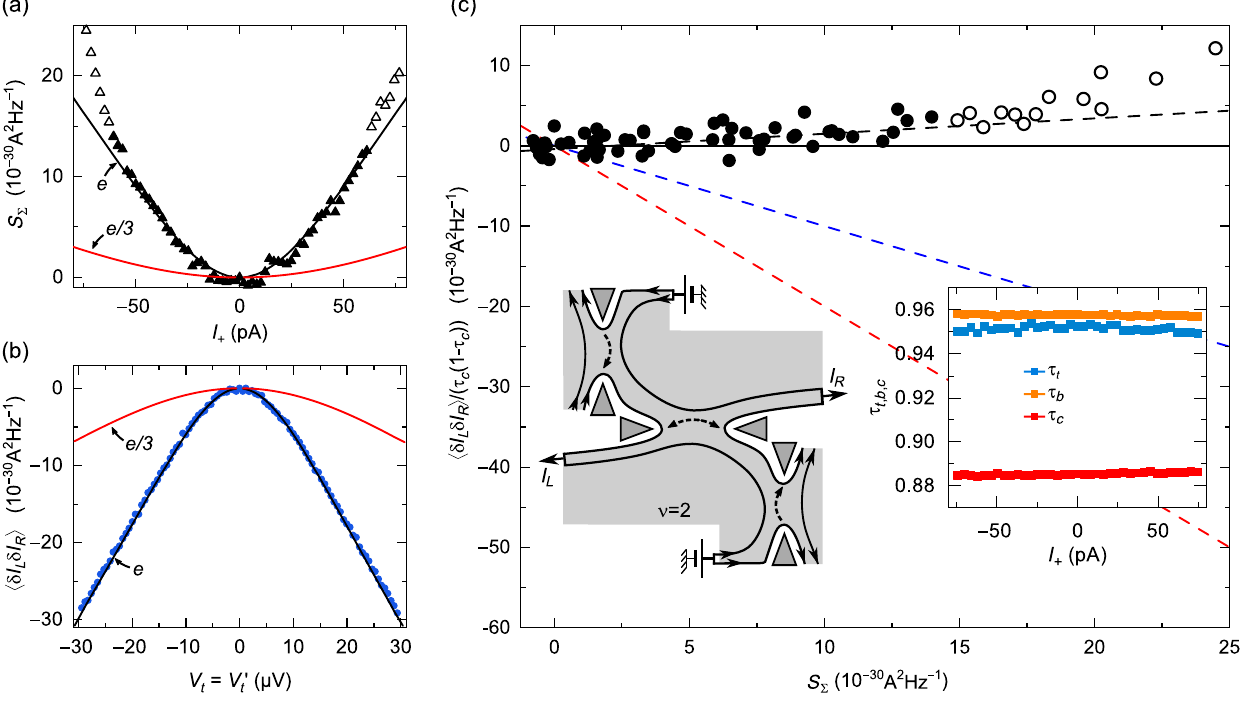
≃ τ ≃ 0 . 96 and τ ≃ 0 . 88 ; see t b c 0 corresponding to a V 0 and V t ¼ b ¼ t (a) and e (b). Symbols display the t;b c